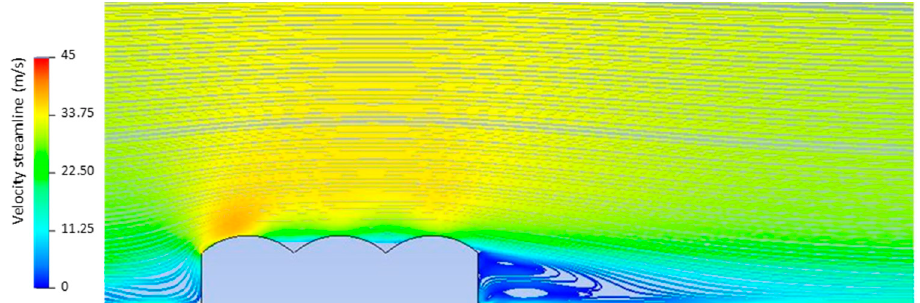
Figure 17. Wind velocity on the streamlines.